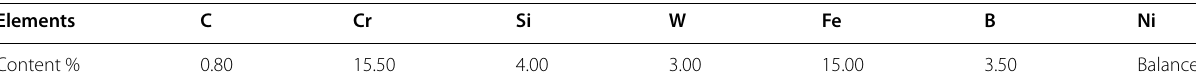
Table 3 Chemical composition of Ni60 powders (wt%) Elements C